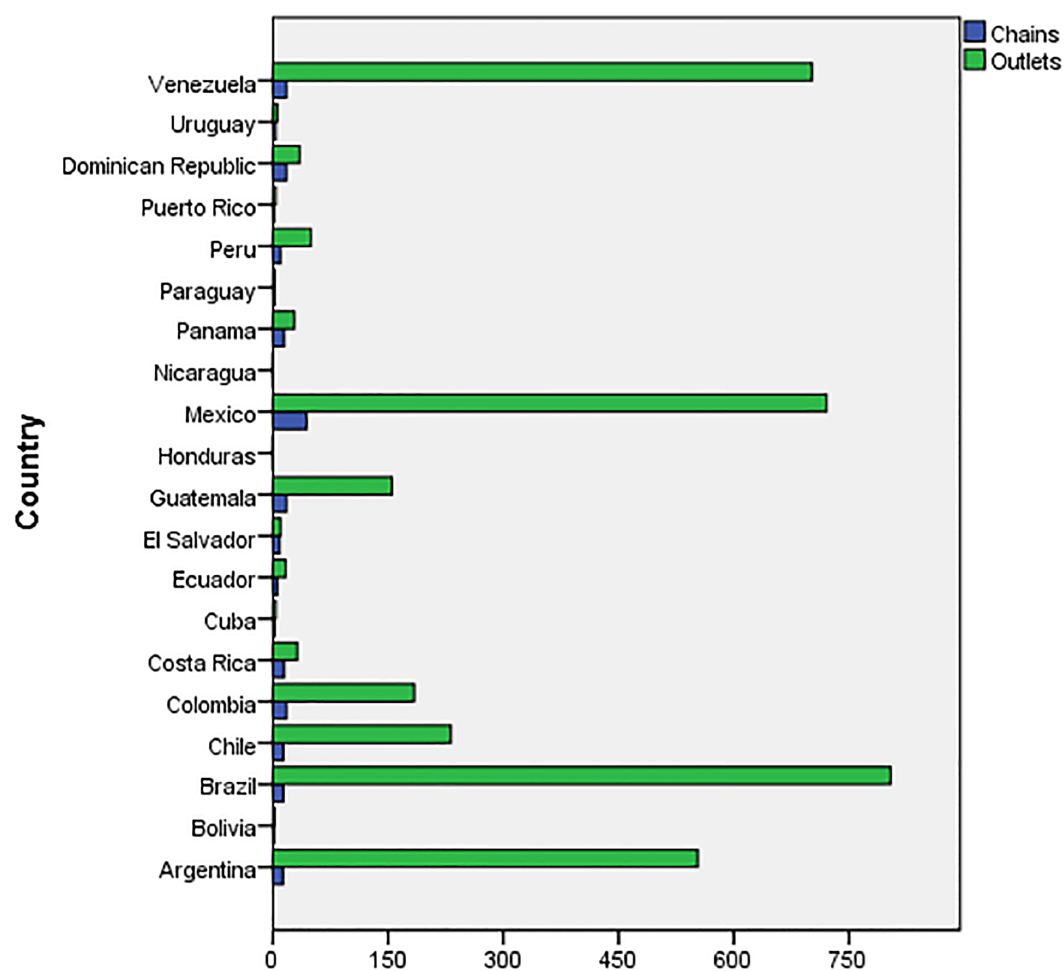
Fig 1. Distribution of Spanish chains and outlets in Latin American